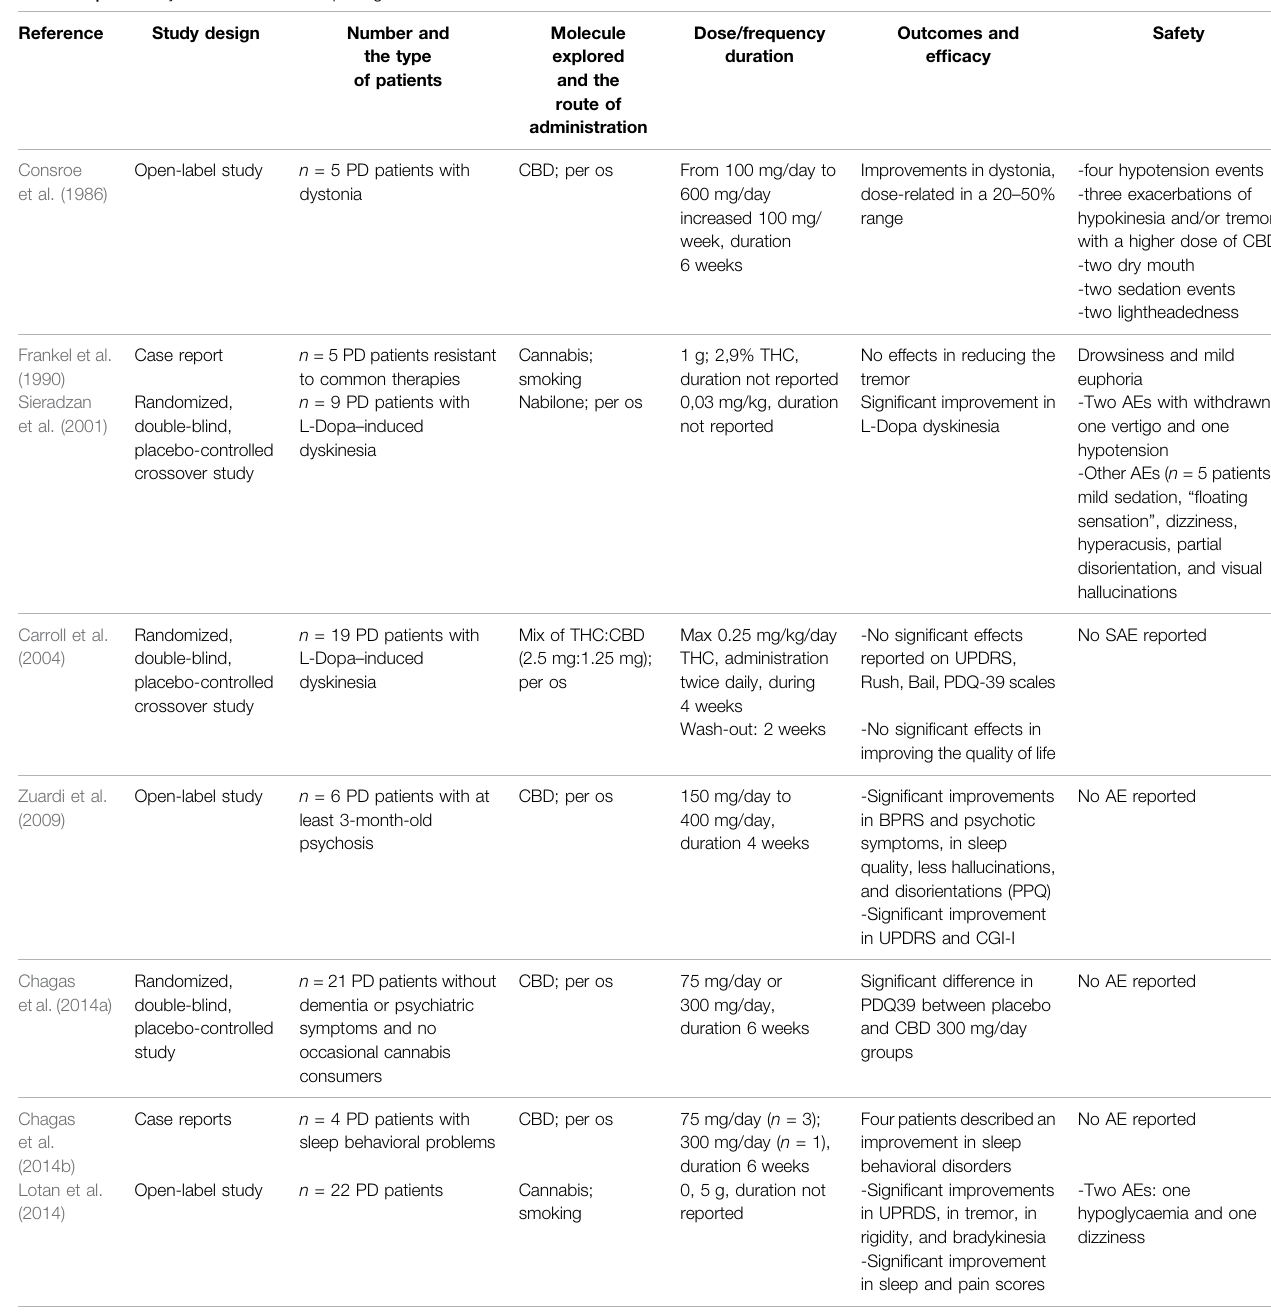
TABLE 2 | Summary of clinical studies exploring medical cannabis in